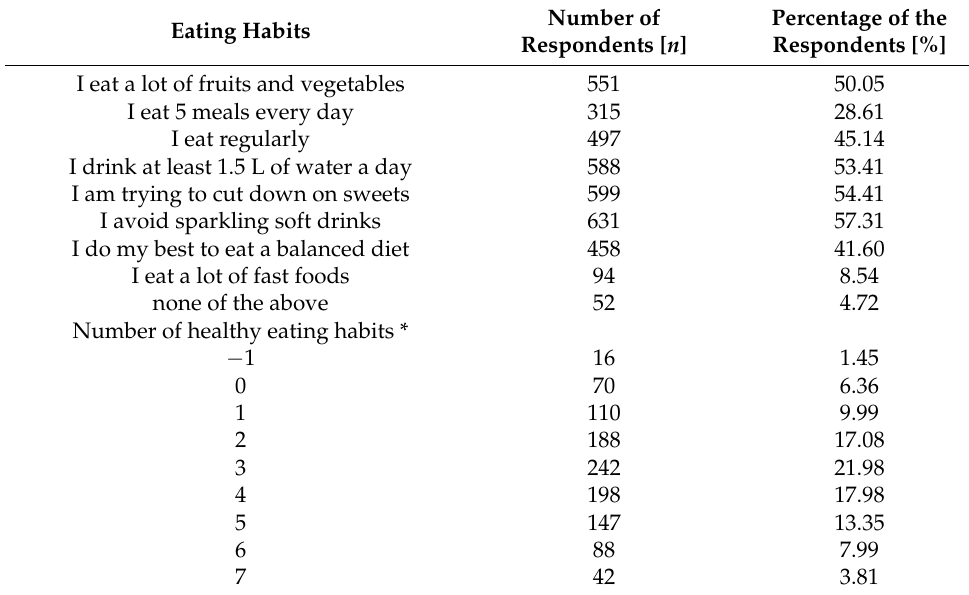
Table 3. Analysis of dietary habits for Poles during the COVID-19